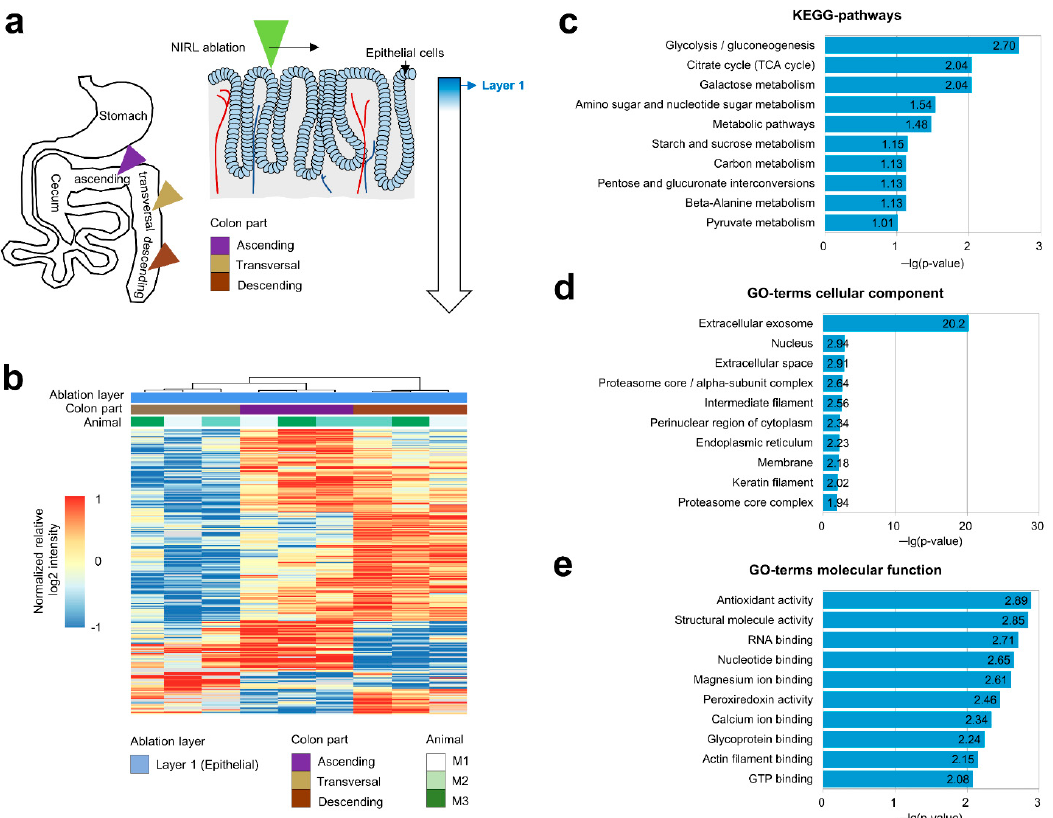
Figure 1. Comparison of epithelial protein signatures across different consecutive colon segments. ( a ) Schematic overview of the colon structure and the spatial location of ablated epithelial samples. ( b ) Hierarchical clustering of proteins between ascending, transversal, and descending colon